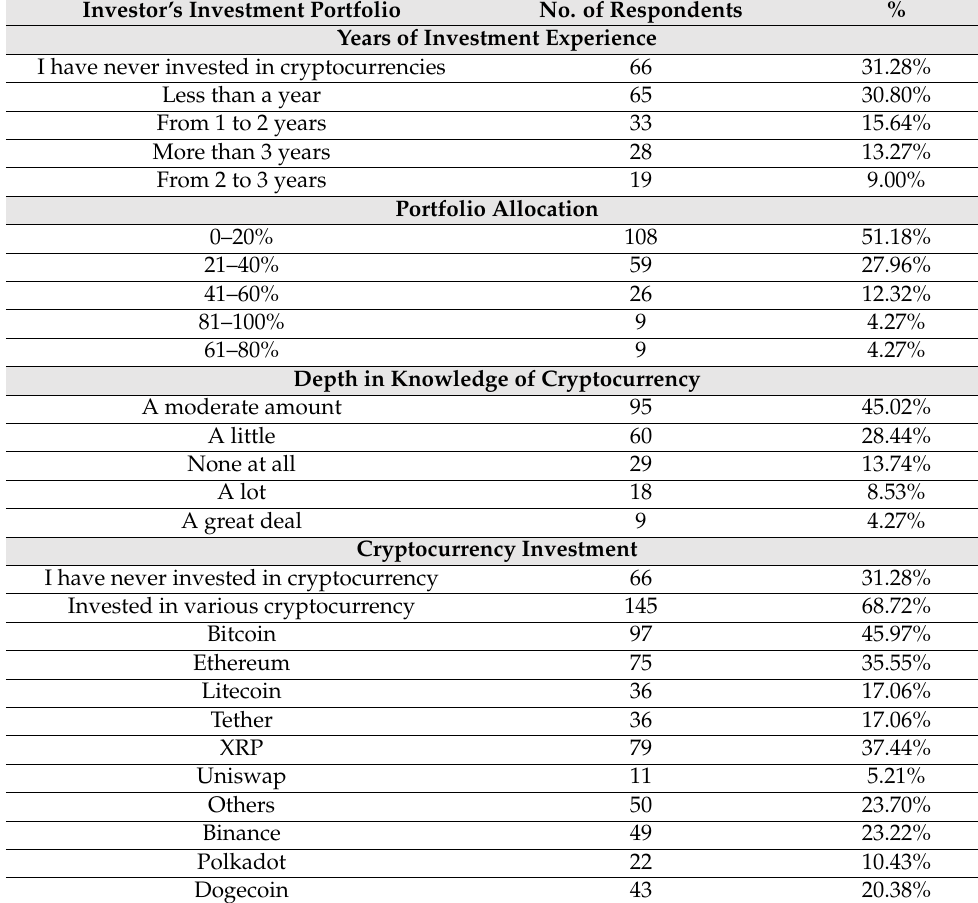
Table 3. Investors’ investment